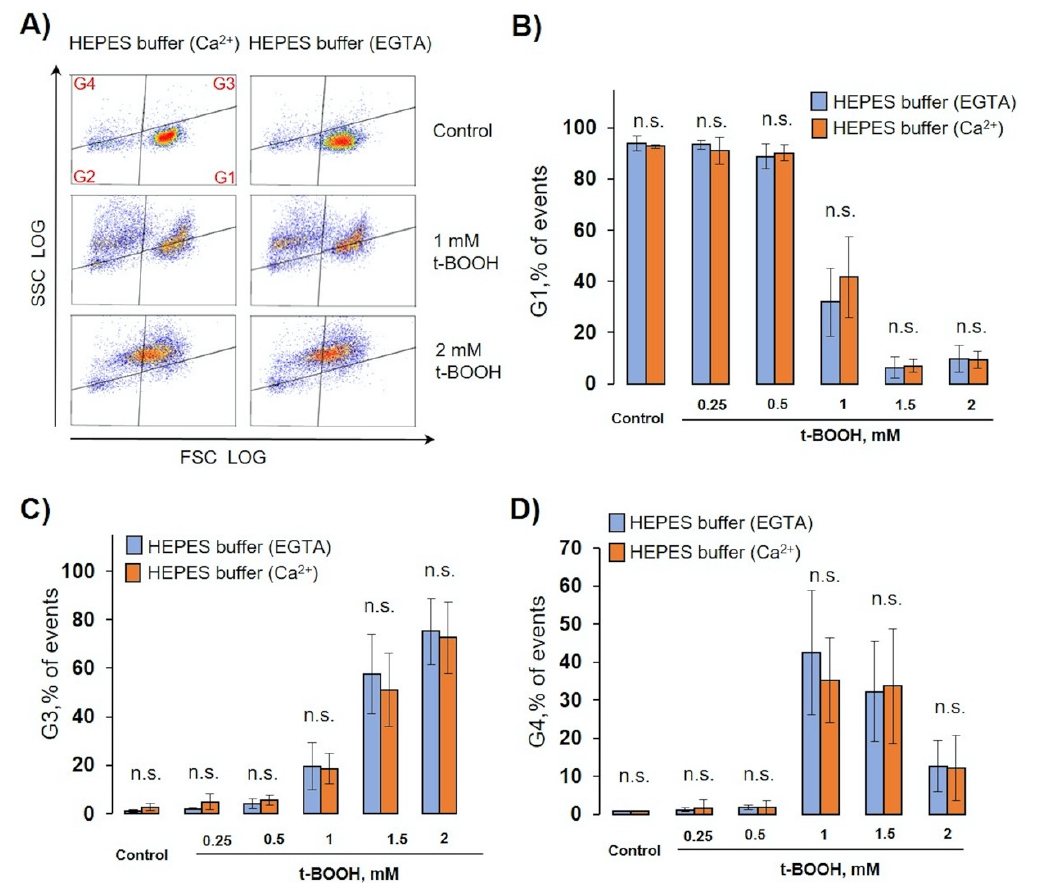
Figure 7. OS-induced RBC transformation and MV formation were calcium-independent. RBCs (0.5 × 10 9 cells/mL) were incubated with the indicated concentration of t-BOOH in HEPES buffer containing 2 mM calcium, or 2 mM EGTA, for indicated times and were analyzed by flow cytometry. ( A ) Representative SSC/FSC dot plots of one out of six independent experiments for 24 h. Template and gating correspond to Section 3.2. ( B – D ) Calculation of events distributed in the corresponding gates. Data are presented as mean ± SD ( n = 7), paired t -test; n.s., not significant.